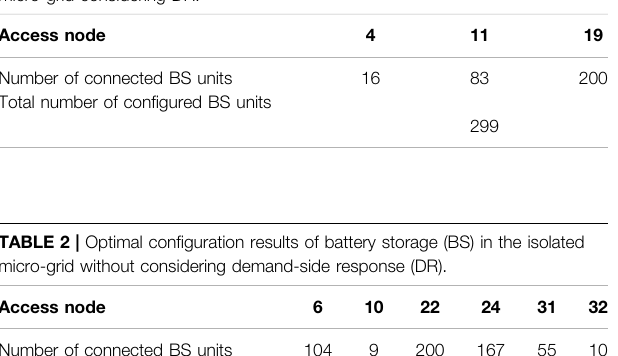
Figure 4 . Then, the simulation time of the BS optimal con fi guration model T(96 h) can be obtained, including the number of BS working cycles, L = 4. Additionally, both are set as 0.1%.